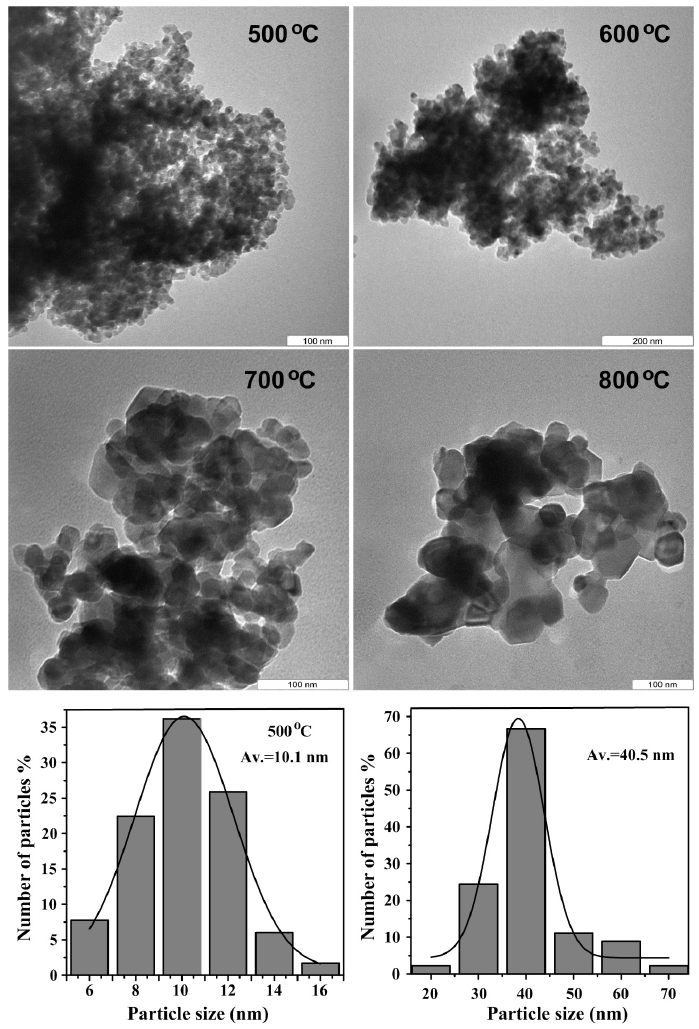
Figure 5. Transmission electron microscopy (TEM) images of TiO 2 nanoparticles at different calcination temperatures and the size distribution histogram for samples calcined at 500 and 800 °C, respectively.